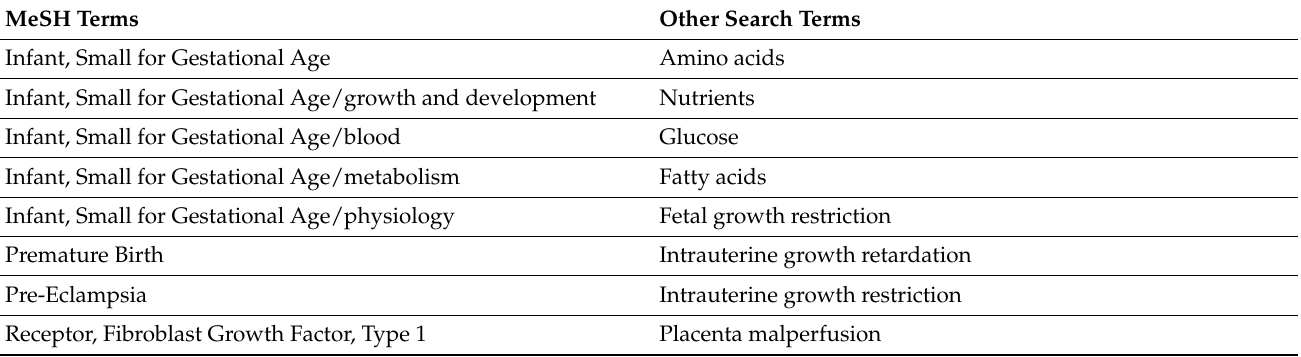
Table 2. Search terms on adverse outcomes and health effects including MIEs and KEs used in AOP helpFinder